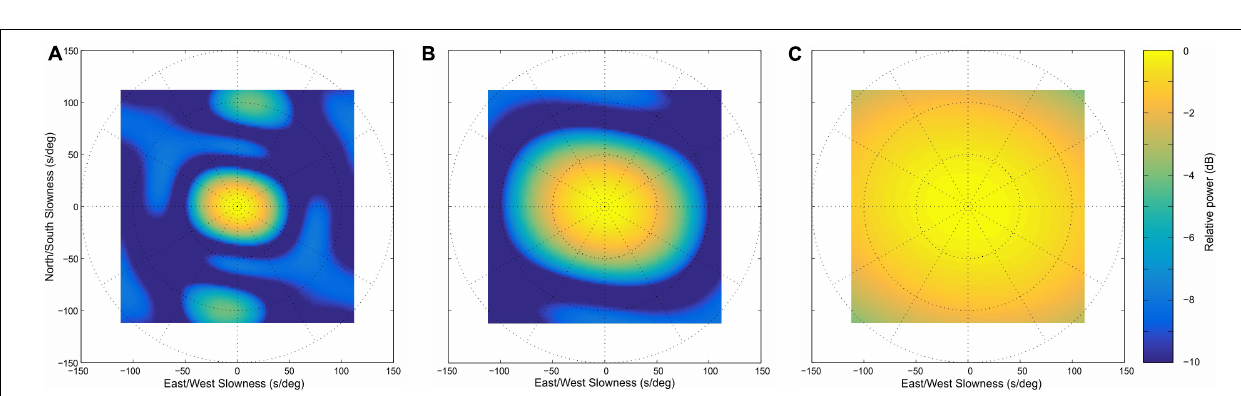
Frontiers in Earth Science |